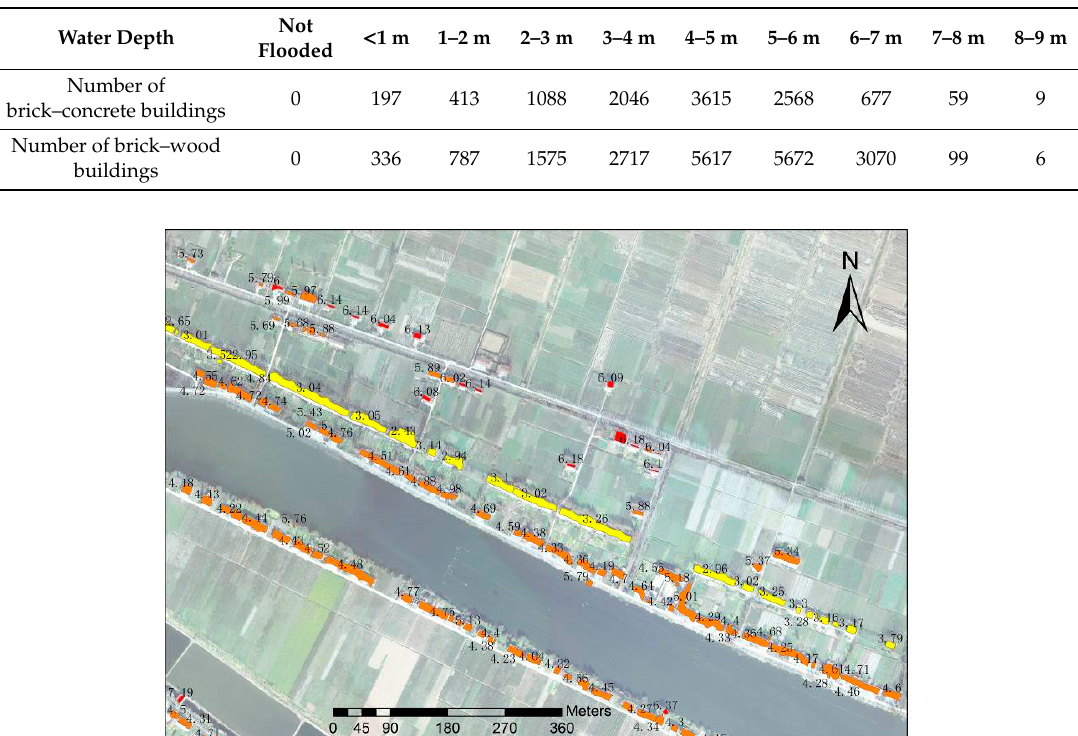
Figure 12. Example map showing submerged buildings of both types; yellow indicates a water depth of 2–4 m, orange 4–6 m, and red >6 m.